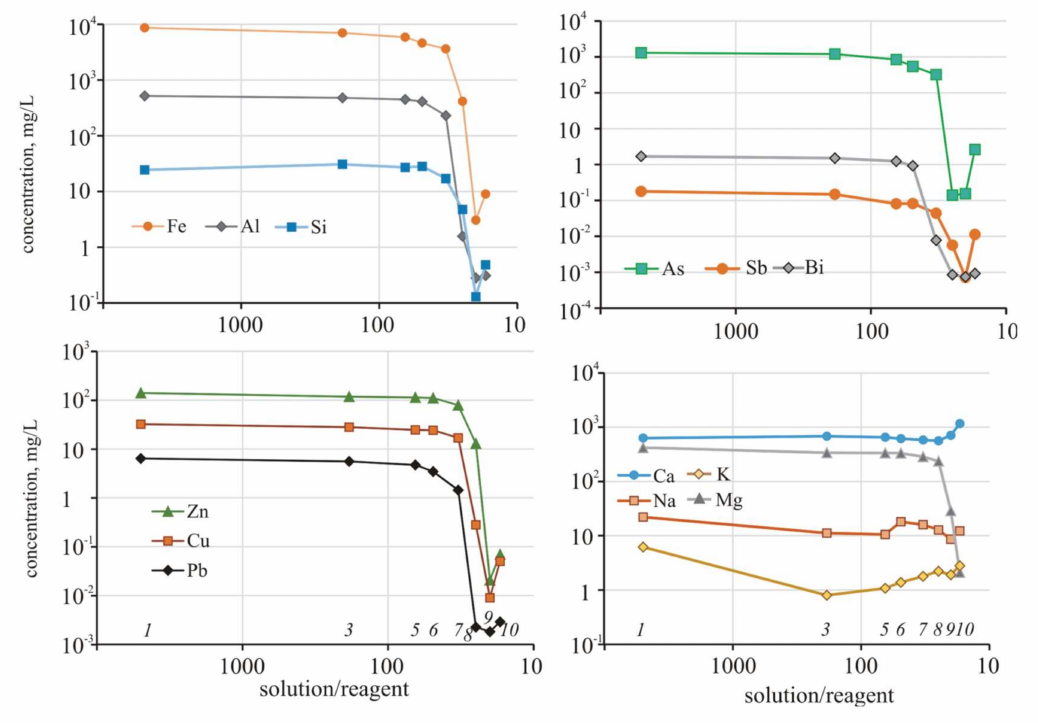
Figure 3. Changes in the elemental concentrations during the experiment with Ca(OH) 2